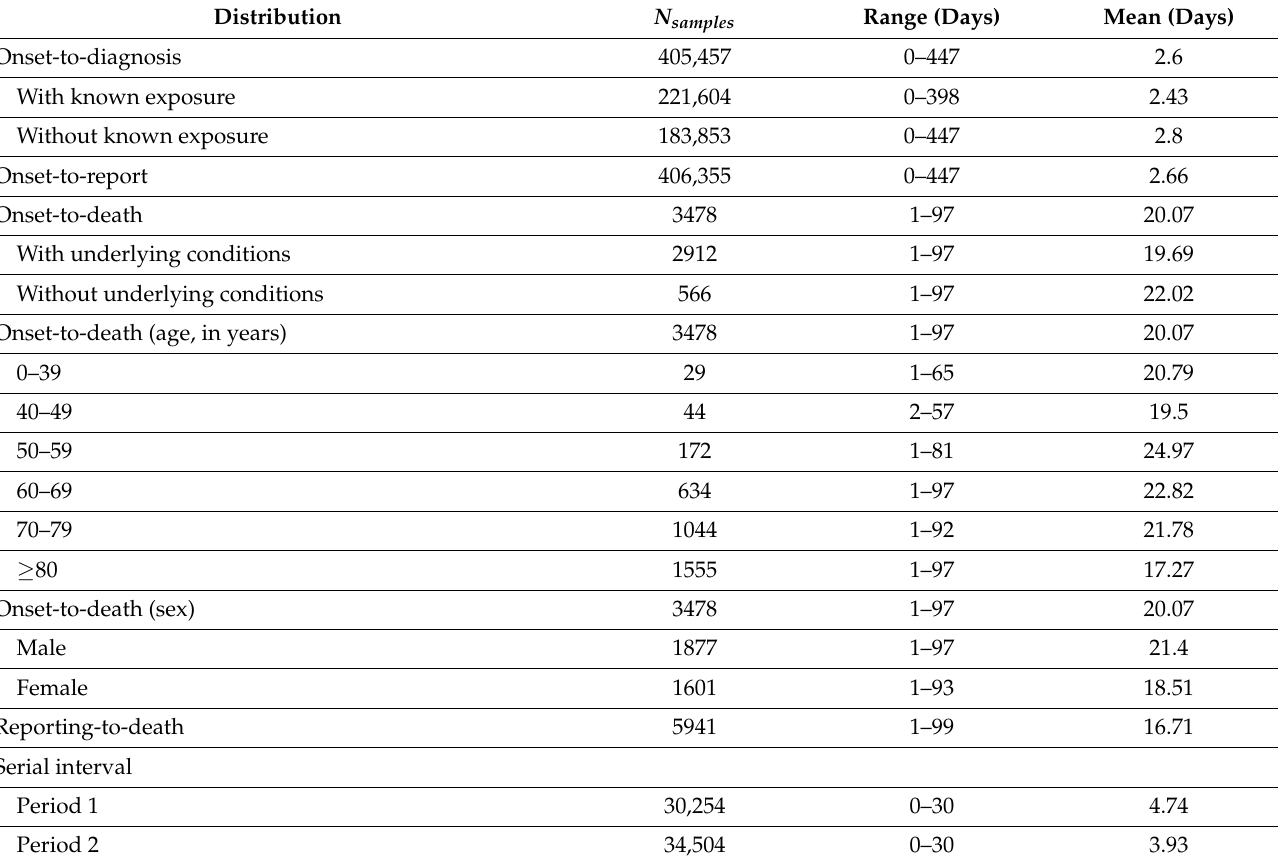
Table 1. Summary of the distribution data analyzed in the study.